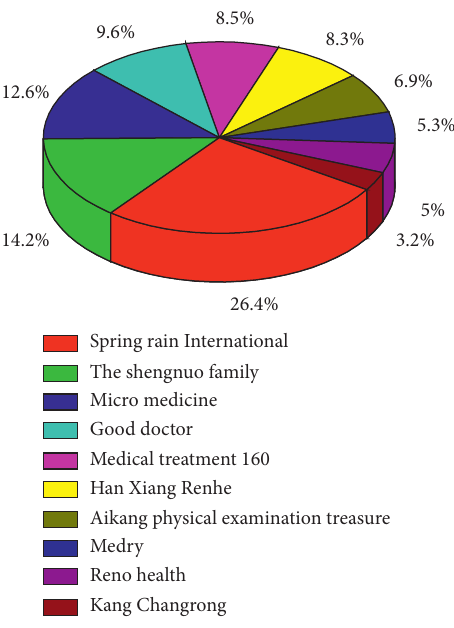
Figure 4: Proportion of Health care tourism industry market of